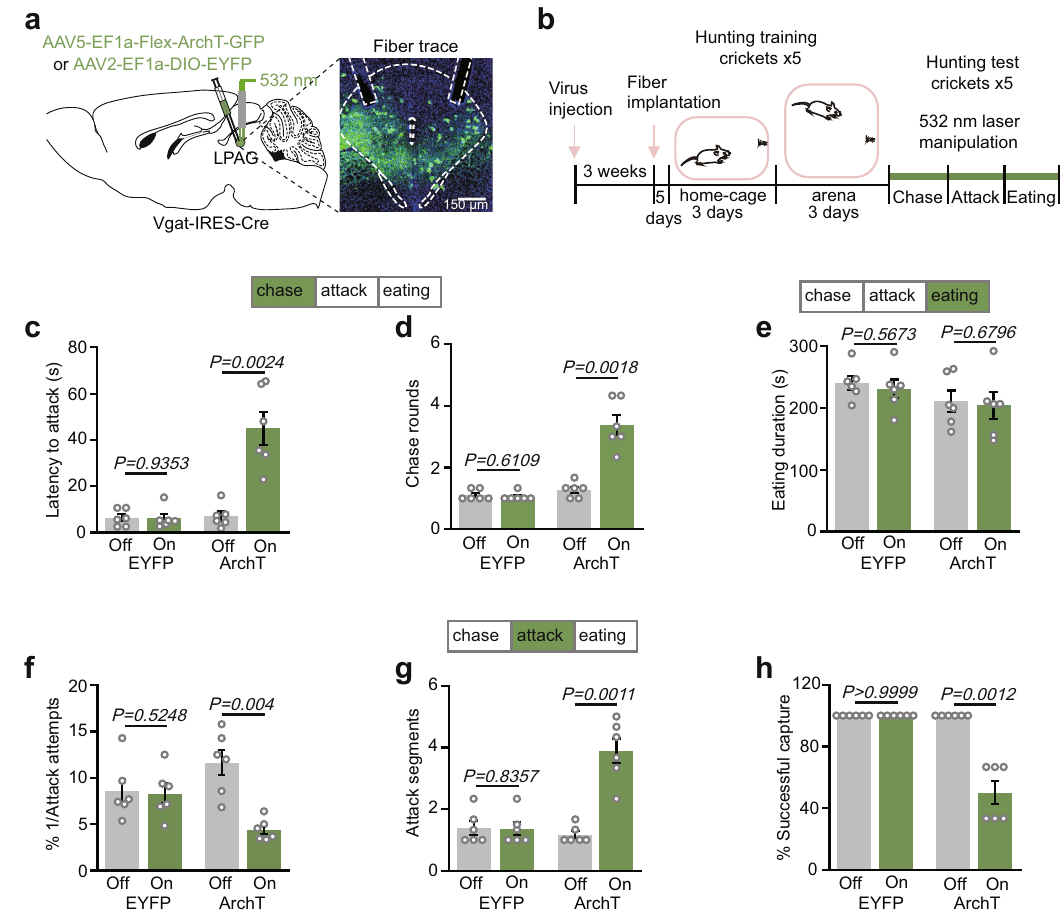
Fig. 3 Phase-speci fi c inhibition of LPAG Vgat neurons suppresses hunting. a Left, scheme for photoinhibition of LPAG Vgat neurons. Right, histology of injection sites and fi ber traces in the LPAG ( n = 6 mice). Scale bar, 150 μ m. b Experimental protocol of the photoinhibition. c , d Changes in latency to attack ( c ) and chase rounds ( d ) after bilateral photoinhibition of LPAG Vgat neurons in the chase phase ( n = 6 mice for each group, two-tailed paired t test). The laser (532 nm, 12 mW, continued) was turned on between the chase onset and the fi rst attack and turned off if mice left the prey. Latency to attack was the time taken from the cricket introduction to the fi rst attack. Chase rounds were the number of prey chases before the fi rst attack. e Changes in eating duration after bilateral photoinhibition of LPAG Vgat neurons in the eating phase ( n = 6 mice for each group, two-tailed paired t test). The 532-nm laser (12 mW, 30-s on/30-s off cycles) was turned on when the mouse began to eat the cricket and turned off when the mouse stopped eating. The eating duration was the time taken from the beginning of eating until the eating stopped. f – h Changes in attacking ef fi ciency ( f ), attack segments ( g ), successful rate ( h ) after bilateral photoinhibition of LPAG Vgat neurons in the attack phase ( n = 6 mice for each group, two-tailed paired t test). 532-nm laser (12 mW, continued) was turned on between the fi rst attack and successful prey capture or failure (6 min time out). Attack ef fi ciency was 1/attack attempts before capture, and attack attempts were the sum of jaw and forepaw attacks during the whole attack phase. Each segment ends when mice leave the prey. The capture success rate was the percentage that the mouse successfully captured crickets. Data are presented as the mean ± SEM. P values are indicated in all panels. Source data are provided as a Source Data